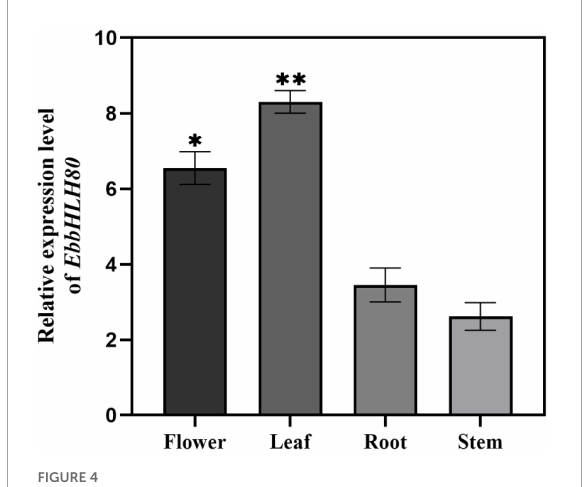
FIGURE4 Relative expression of EbbHLH80 in the different tissues of E. breviscapus . Data represent mean ± SD of three biological replicates and the one-way analysis of variance was used for statistical analyses ( ∗ P < 0.05; ∗∗ P < 0.01).